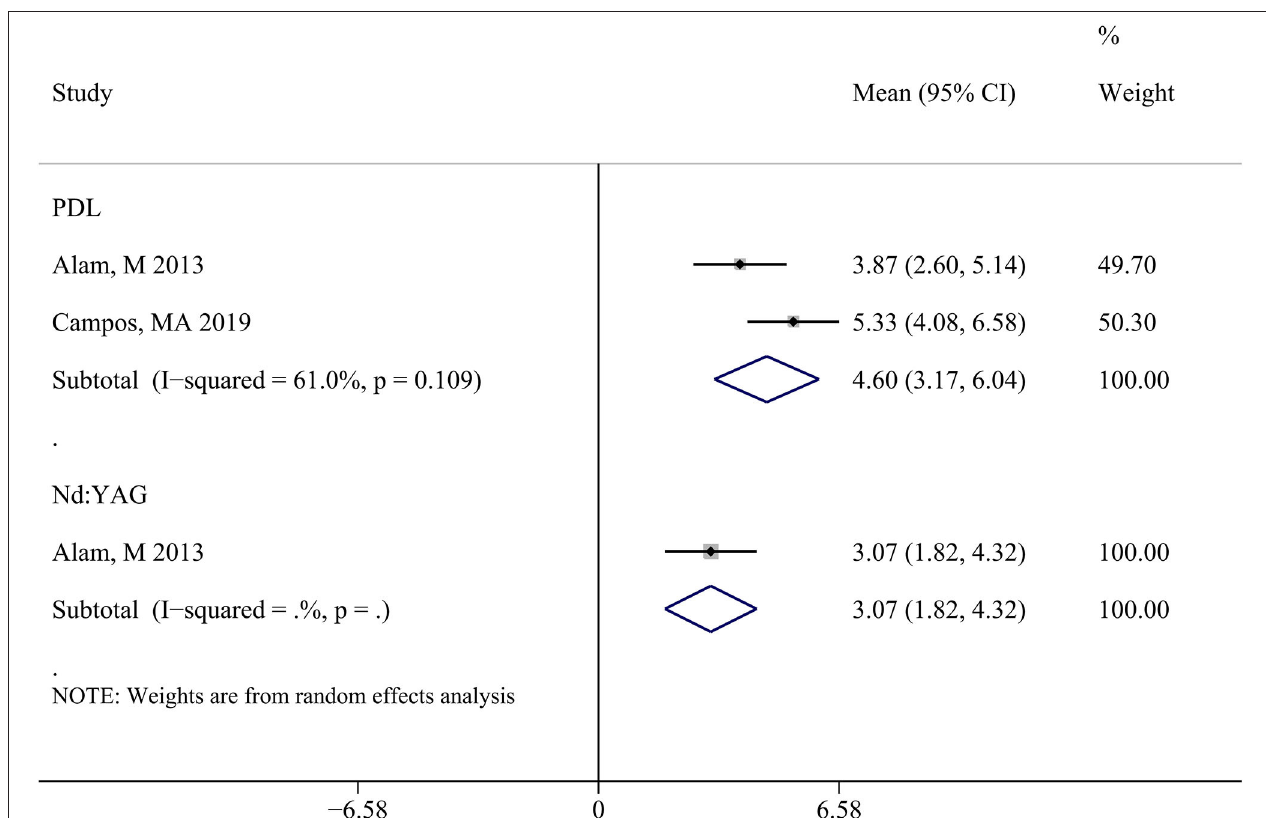
FIGURE 5 | Forest plot of standard mean difference to compare pain score between PDL and Nd:YAG groups. PDL, pulsed dye laser; Nd:YAG,